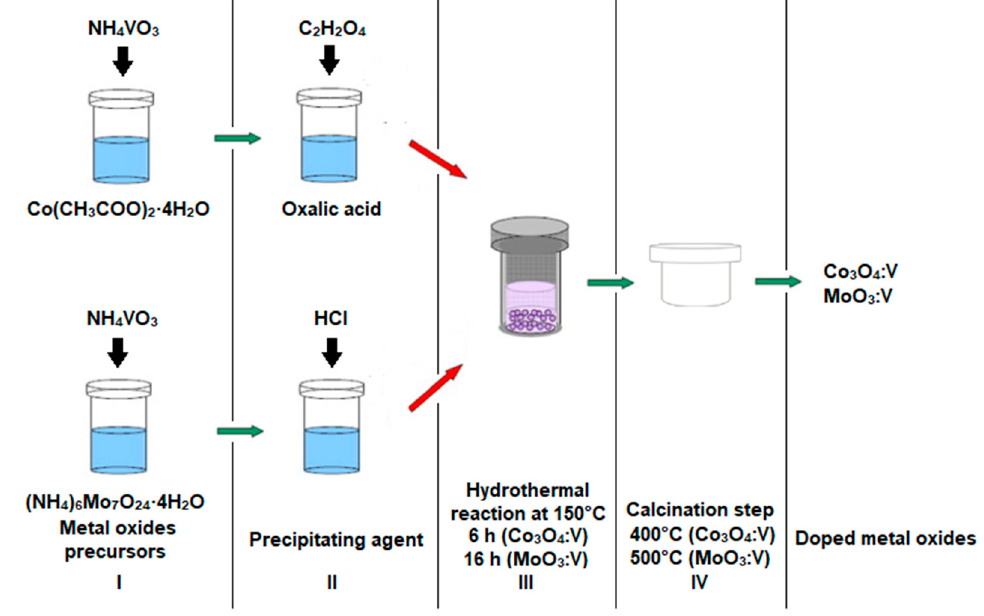
Figure 1. Schematic representation of the hydrothermal synthesis procedure used in this work to obtain two metal oxides MOs with vanadium guest species, namely Co 3 O 4 :V and MoO 3 :V.